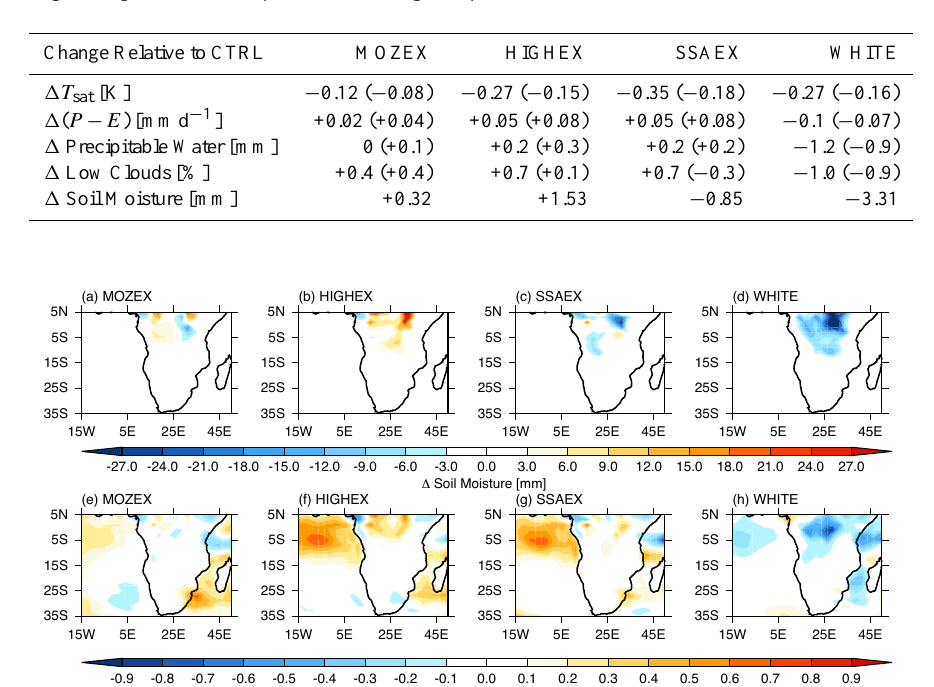
Table 3. Summary of ASO area-weighted average (3 ◦ N–37 ◦ S, 19 ◦ W–50 ◦ E) changes in surface air temperature ( T sat ; K), precipitation minus evaporation ( P − E ; [mmd − 1 ]), column-integrated precipitable water vapor (WVP) [mm], low-level clouds [%], and soil moisture [mm]. Land-only averages are given with land plus ocean averages in parenthesis.